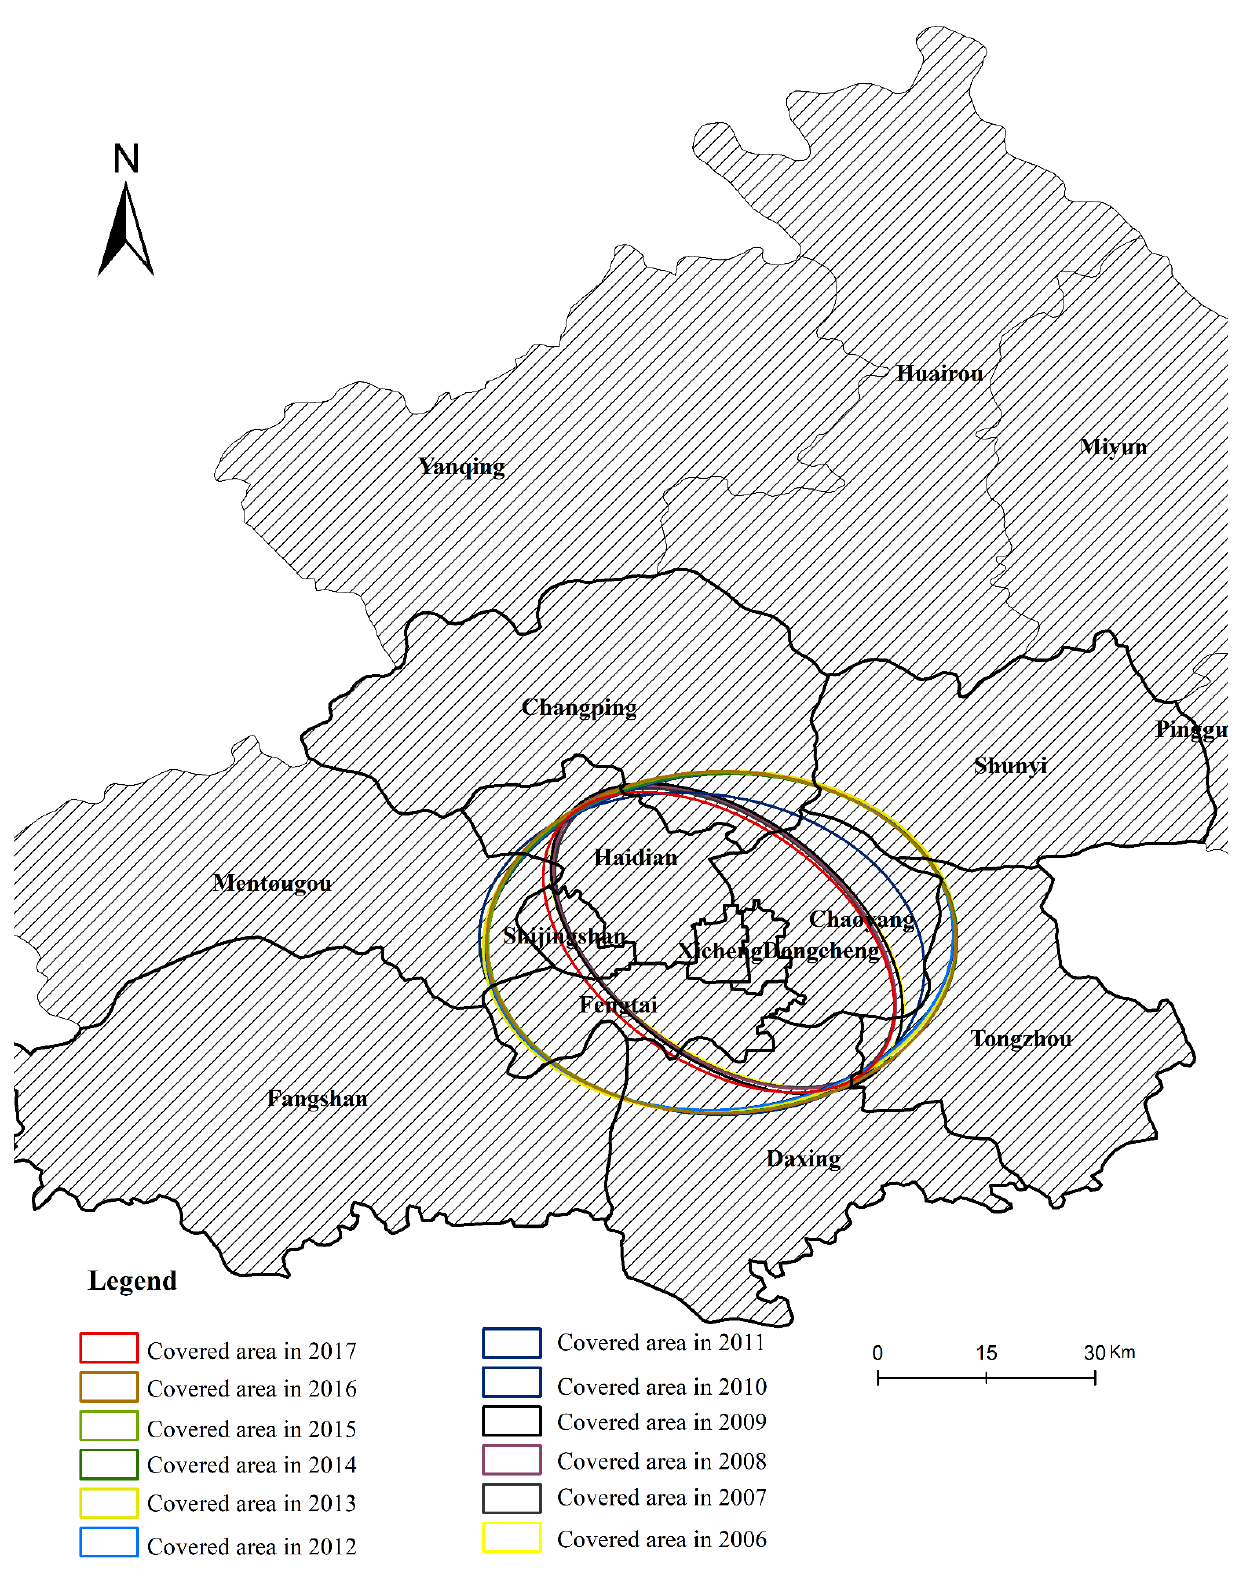
Figure 7. Evolution of the spatial distribution center and scope of overall coupling coordination degree in Beijing from 2006 to 2017.